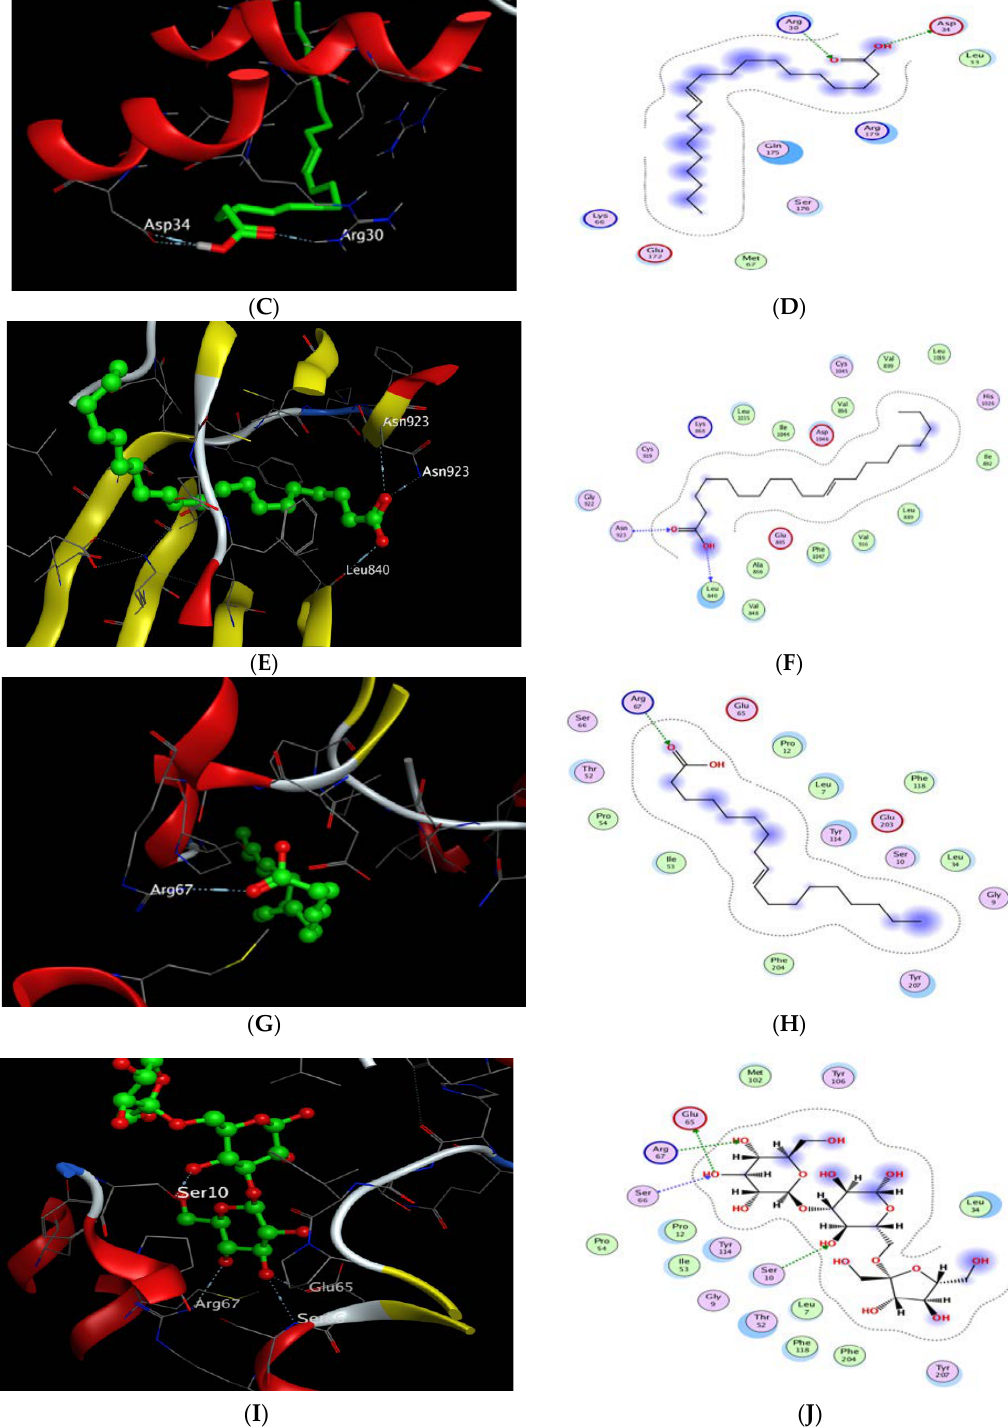
Figure 8. ( A ) 2D interactions and ( B ) 3D docking pose of gondoic acid in the active pocket site of IL-1β (PDB: 6Y8M) ; ( C ) 2D interactions and ( D ) 3D docking pose of gondoic acid in the active pocket site of IL-6 (PDB: 1ALU); ( E ) 2D interactions and ( F ) 3D docking pose of gondoic acid in the active pocket site of VEGF (PDB: 4AG8); ( G ) 2D interactions and ( H ) 3D docking pose of oleic acid in the active pocket site of GST (PDB: 3EIN); ( I ) 2D interactions and ( J ) 3D docking pose of 3″(1 ‴ - O - β -D- glucopyranosyl)-sucrose in the active pocket site of GST (PDB: 3EIN). Regarding docking with IL-6, its X-ray crystallographic structure complexed with its ligand (tartaric acid) was obtained from the Protein Data Bank through the internet (http://www.rcsb.org/pdb/, code 1ALU) accessed on 2 June 2022. The docking algorithm was able to predict the co-crystalized ligand pose with RMSD 1.758 and an energy score